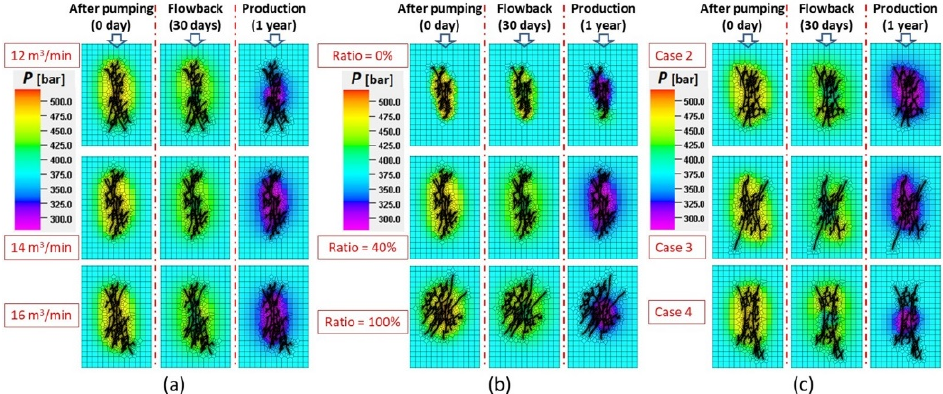
Figure 5. Variation of pressure distribution in oil layer: ( a ) pumping rate. ( b ) slick water ratio. ( c ) cluster spacing.